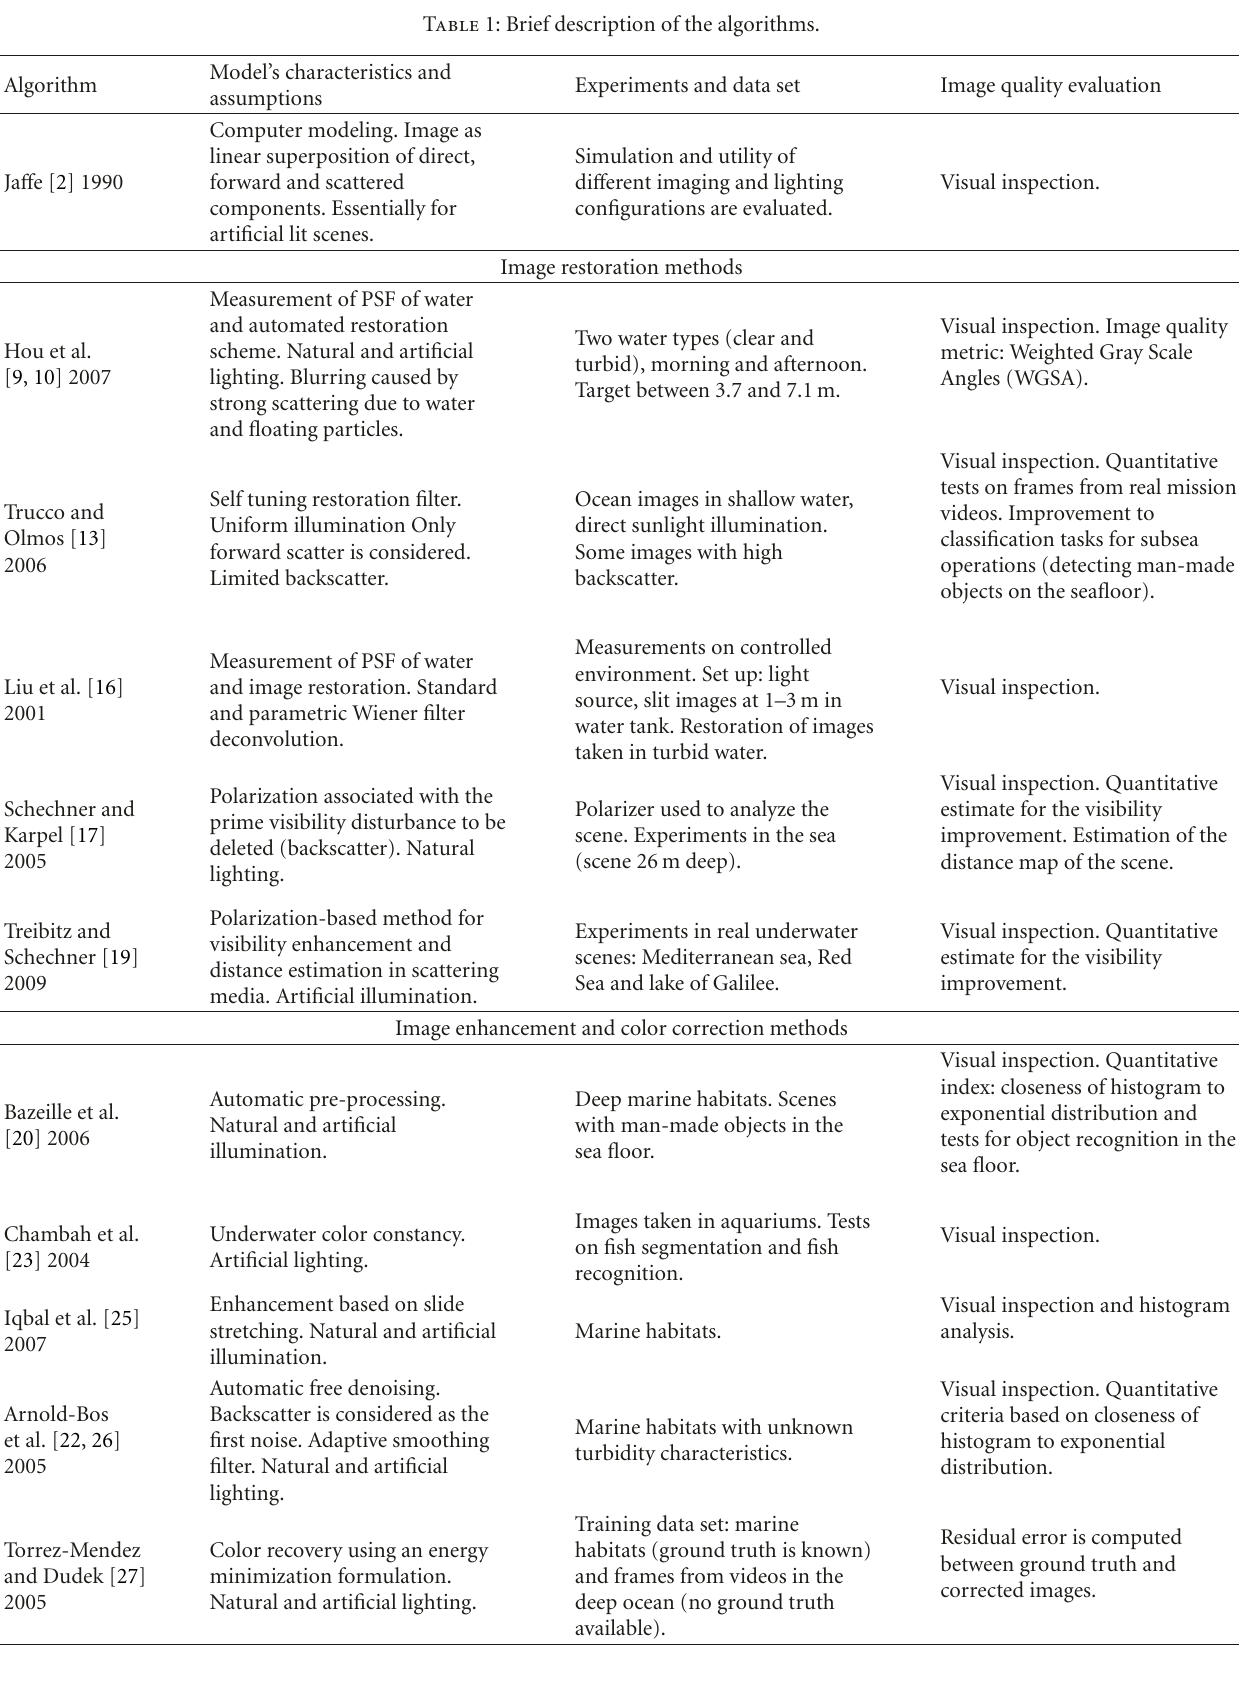
Table 1: Brief description of the